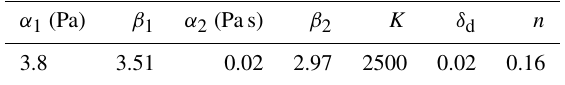
Table 4. Constitutive (rheological) parameters for debris flow sim- ulation.